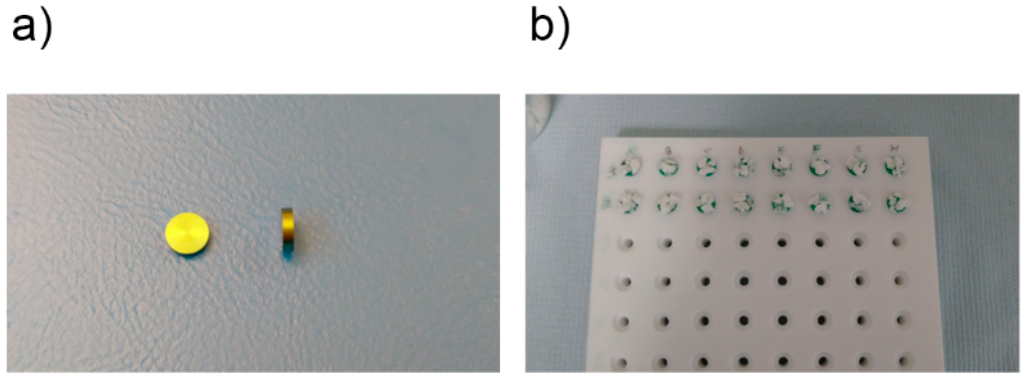
Figure 1. Uncoated titanium disk ( a ); polymer flakes standing on the top of the titanium disks before compression molding ( b ).